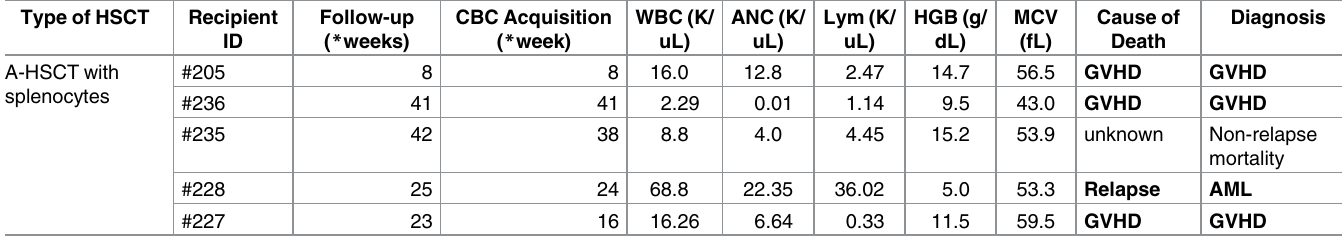
Table 2. Clinical outcome of A-HSCT with induced